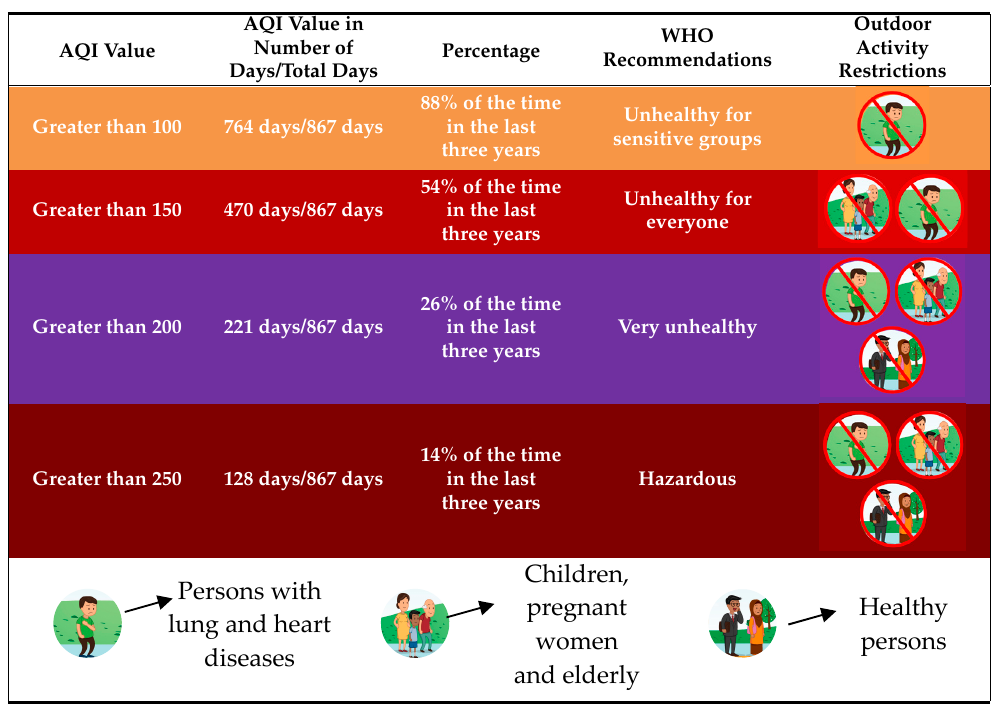
Table 2. Lahore AQI values and their effects on human life.